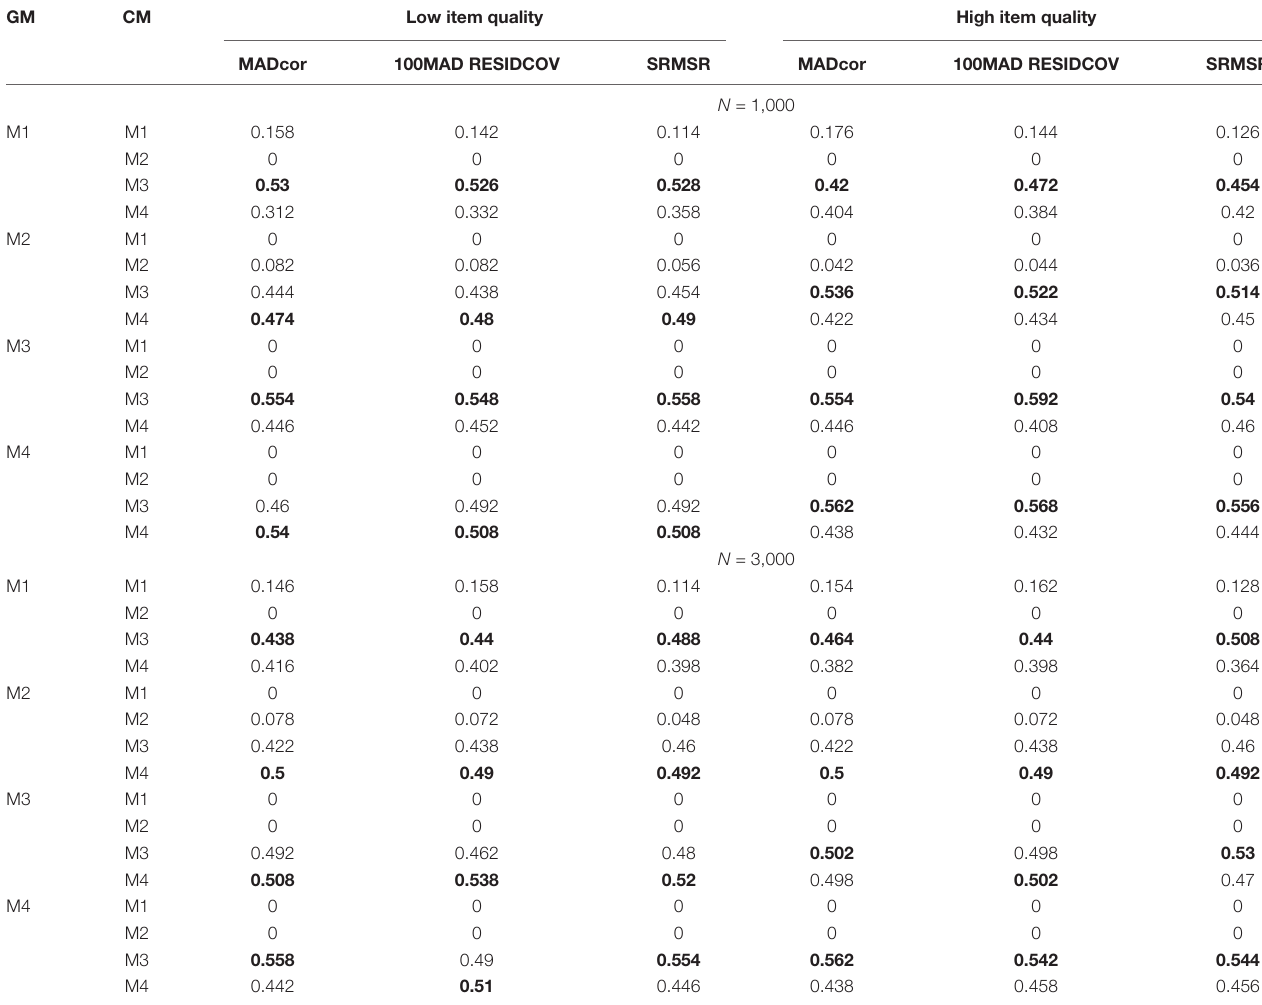
TABLE 9 | CDRs of AFIs for different models with linear attribute structures.